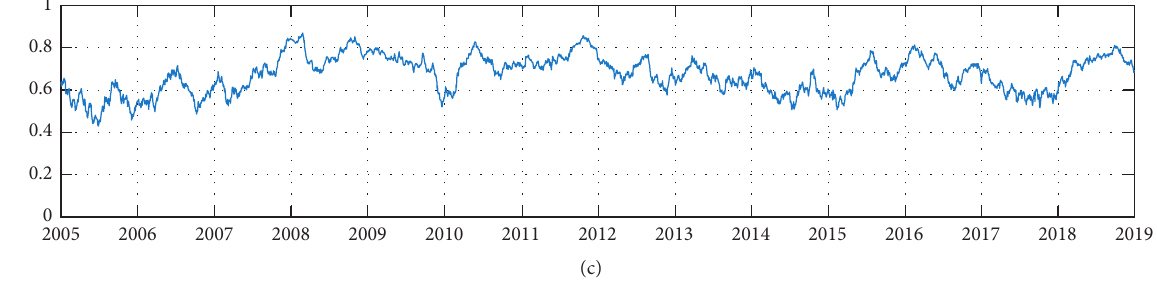
Figure 9: Moving sample Kendall’s tau series of uniform scores. (a) HSI-CEI. (b) HSI-CCI. (c) CEI-CCI.